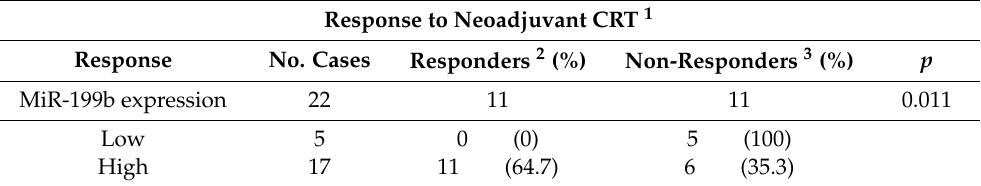
Table 2. Association between response to nCRT and miR-199b expression in liquid biopsies from LARC patients.